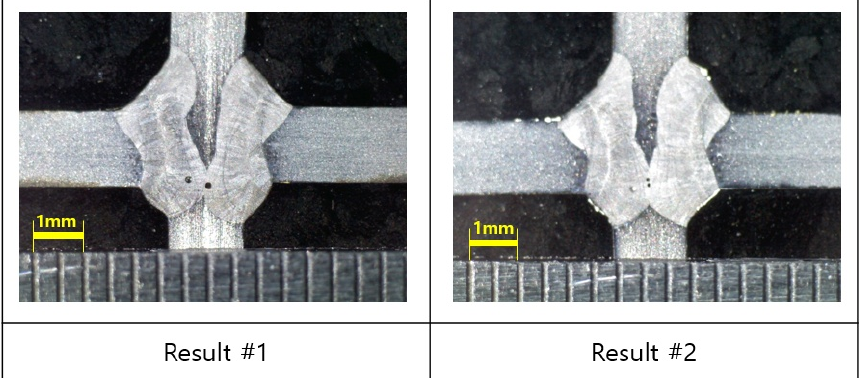
Table 8. Welding conditions of Step 1 (laser power change, 4 cases).